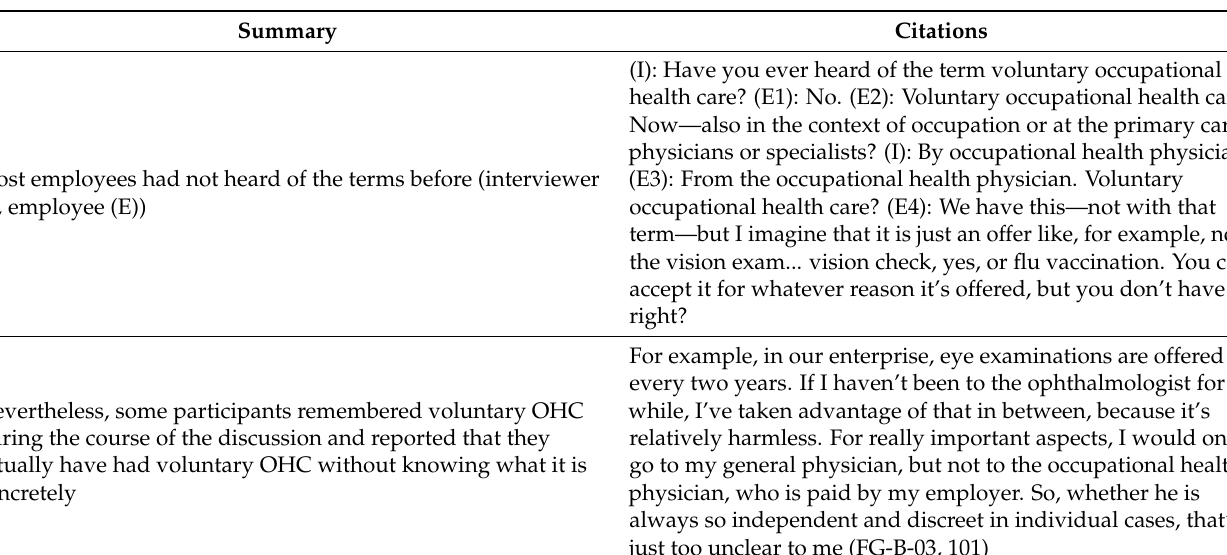
Table A6. Exemplary quotations from employees in interviews and focus discussions to research question 1: Uptake of voluntary occupational health